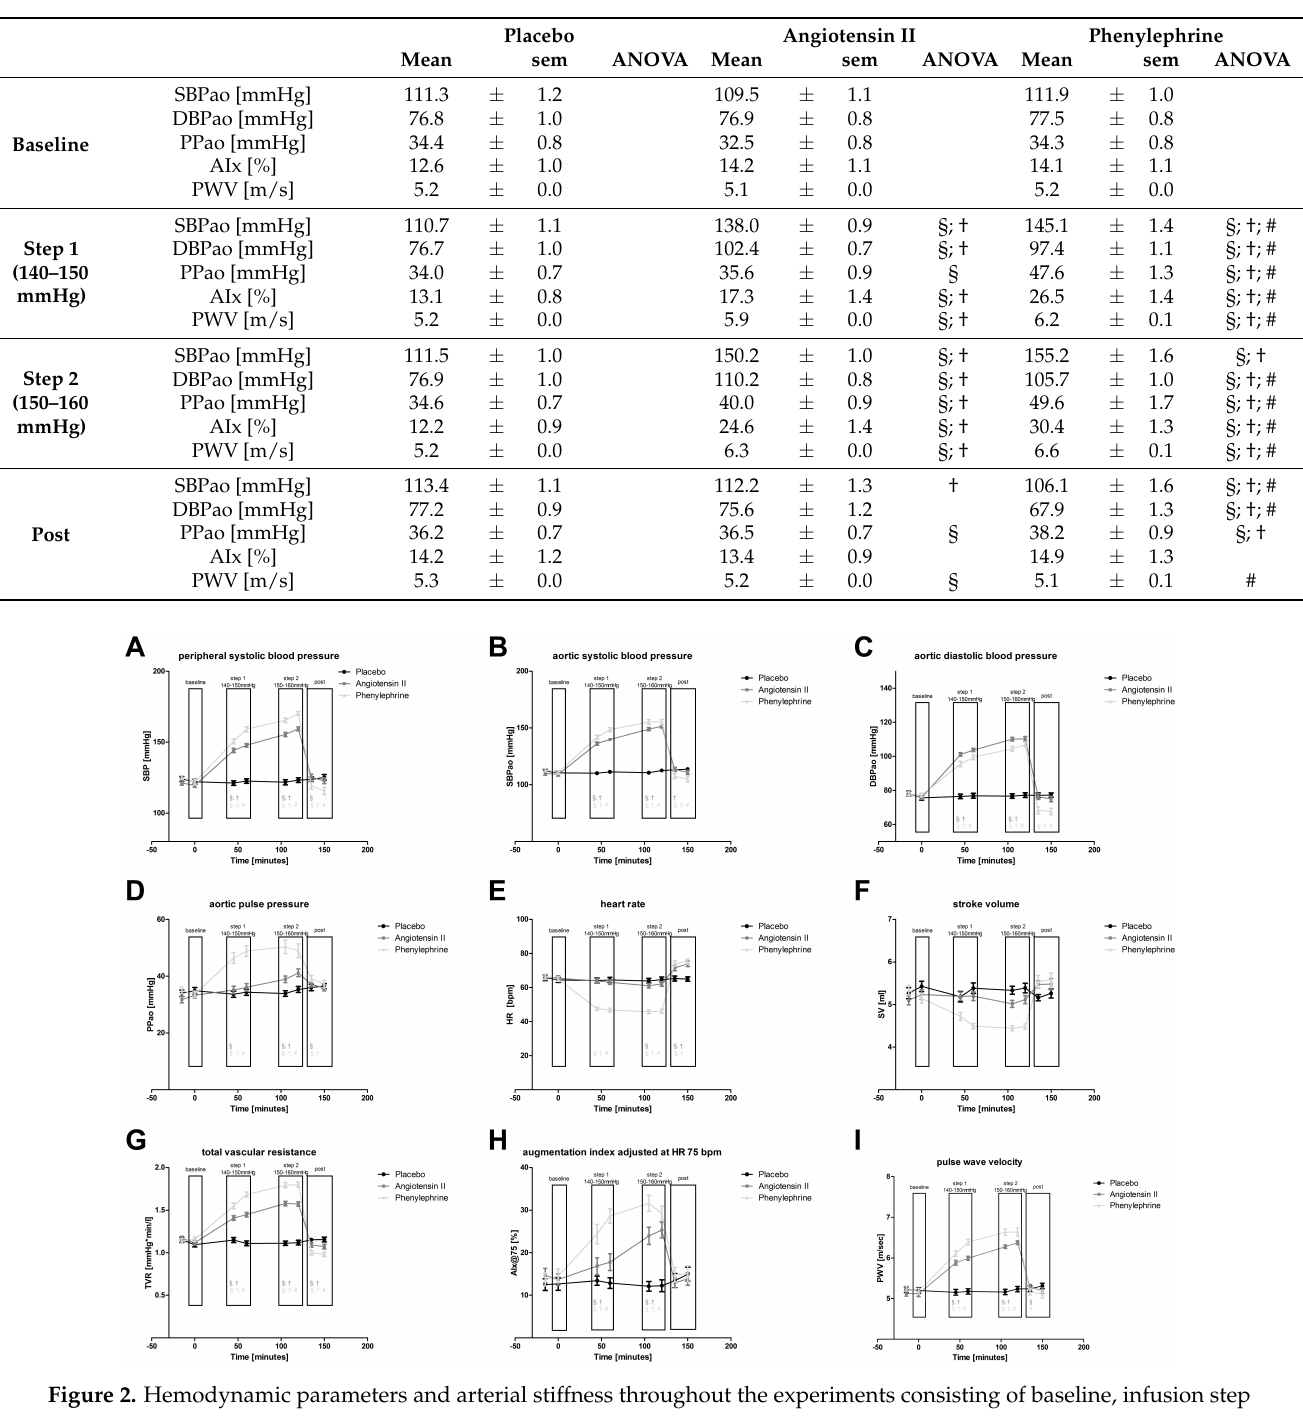
Table 2. Aortic blood pressure (SBPao and DBPao), pulse-wave velocity (PWV) and augmentation index adjusted to HR 75/min (AIx) of all three conditions at different recording periods. Comparison of different periods within condition (ANOVA) § p < 0.05. Comparison of corresponding periods between conditions (ANOVA) † p < 0.05 for Ang II or PE vs. placebo, # p < 0.05 for Ang II vs. PE.